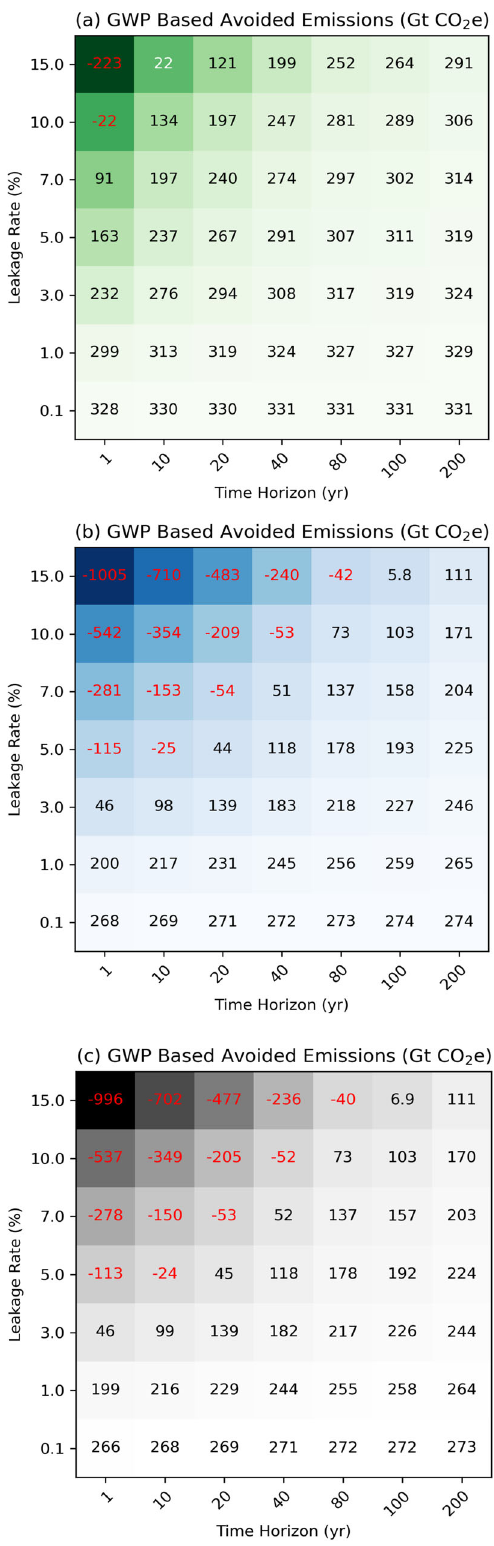
Fig. 4 Abatement of cumulative CO 2 emissions associated with a global energy transition to hydrogen. CO 2 emissions abatement (GtCO 2 e) over the 2030 − 2100 period associated with a worlwide hydrogen economy transition according to the HC2017 scenario and as a function of the leakage rate and GWP time-horizon. The hydrogen CO 2 equivalent emissions are calculated considering ( a ) green, ( b ) blue + green, and ( c ) grey + blue + green hydrogen according to the HC2017 scenario. The net climate penalty conditions (negative emissions) are provided in